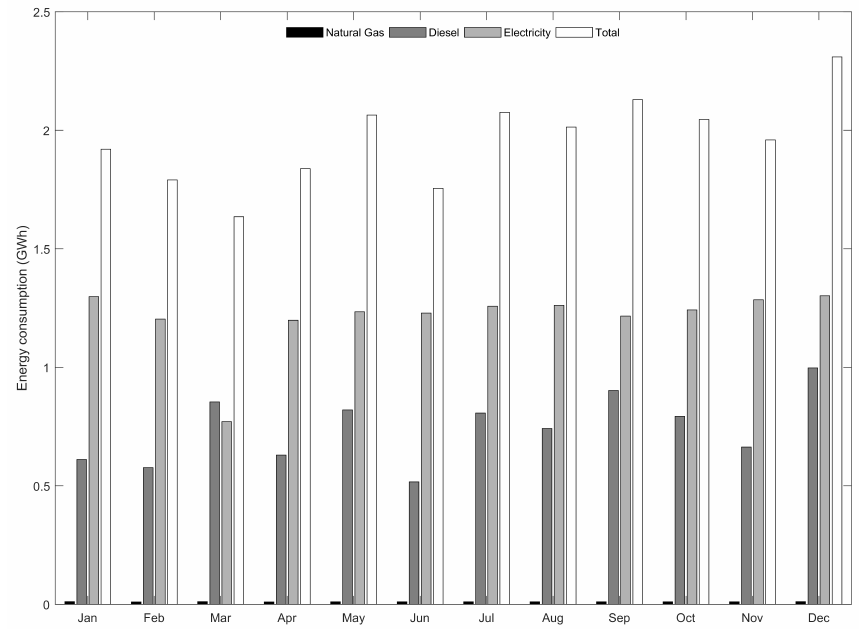
Figure 3. Energy consumption patterns of Port of